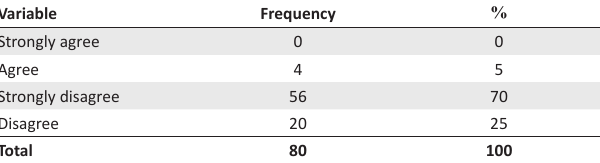
TABLE 3: Amount of paperwork involved in performance management system is not overwhelming and the forms are easy to